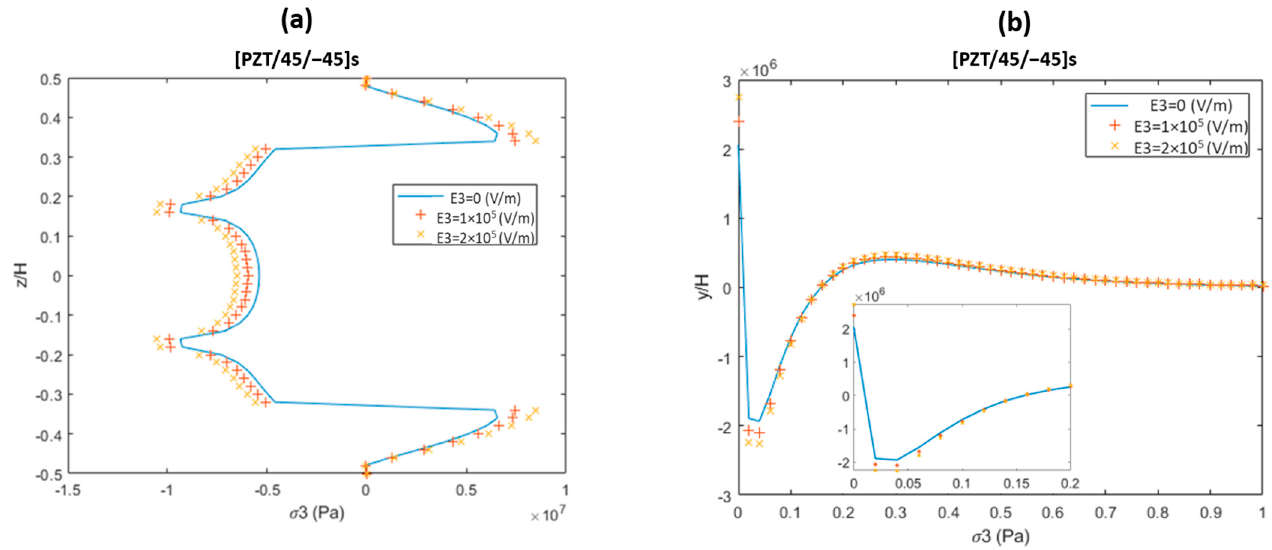
Figure 10. Interlaminar stress σ 3 distribution in angle-ply laminate ( a ) at the free edge and ( b ) at the PZT/45 interface.